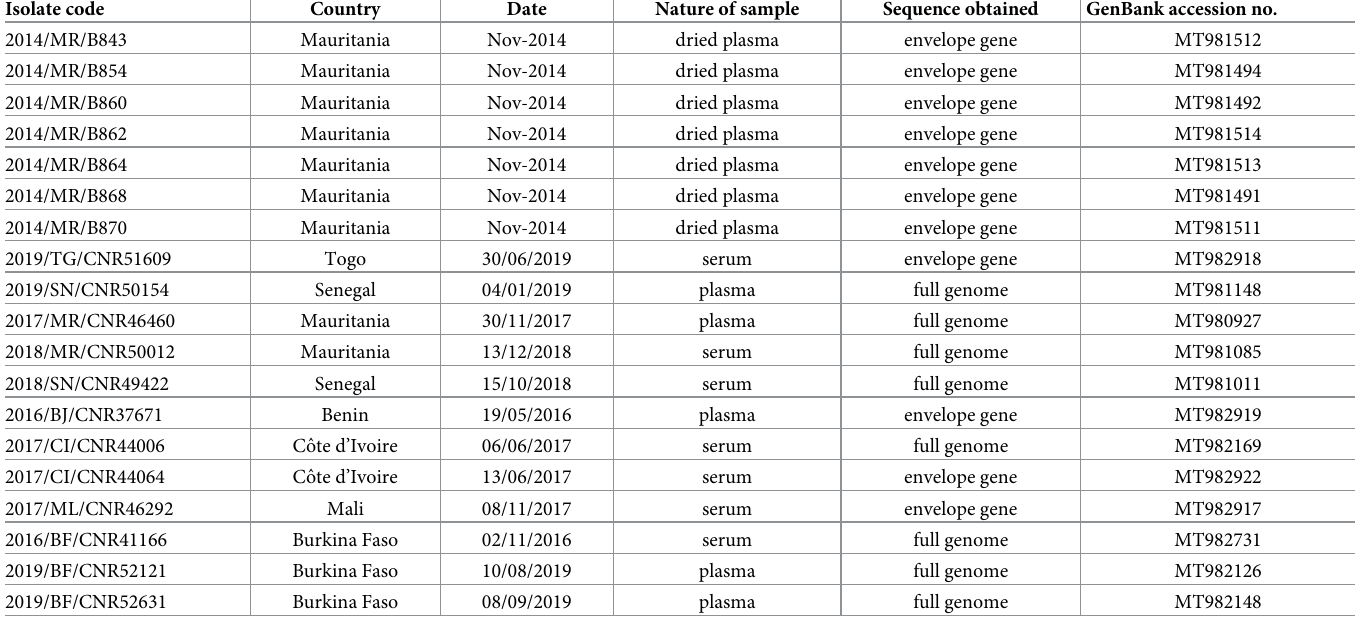
Dengue virus is known to be transmitted through two relatively compartmentalized transmis- sion cycles, with genetically distinct DENV genotypes: sylvatic and urban cycles. Sylvatic DENVs are maintained in a sylvatic enzootic cycle involving non-human primate reservoirs and arboreal mosquitoes ( Ae . luteocephalus , Ae . taylori , Ae . furcifer , Ae . opok and Ae . africanus ) [25]. Spillover infection of the sylvatic cycle may occur and can be responsible for the Table 2. Characteristics of dengue virus strains analyzed in this study. Isolate code Country Date Nature of sample Sequence obtained GenBank accession